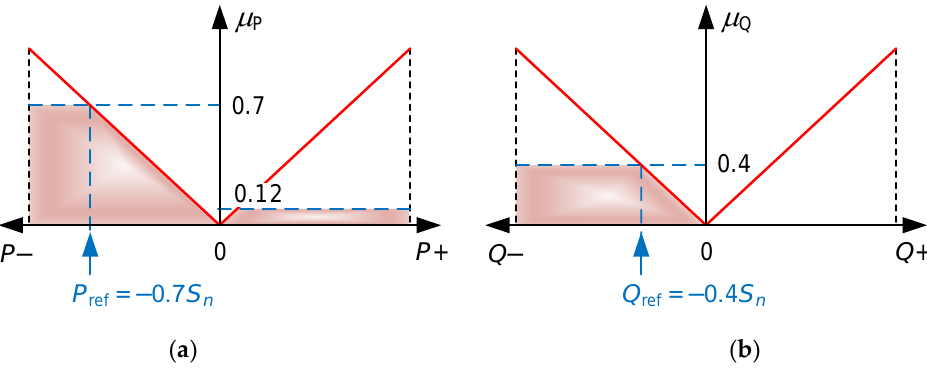
Figure 6. The function of the defuzzification of ( a ) active power values; ( b ) reactive power values; S n is the rated apparent power of the converter of the ESU.